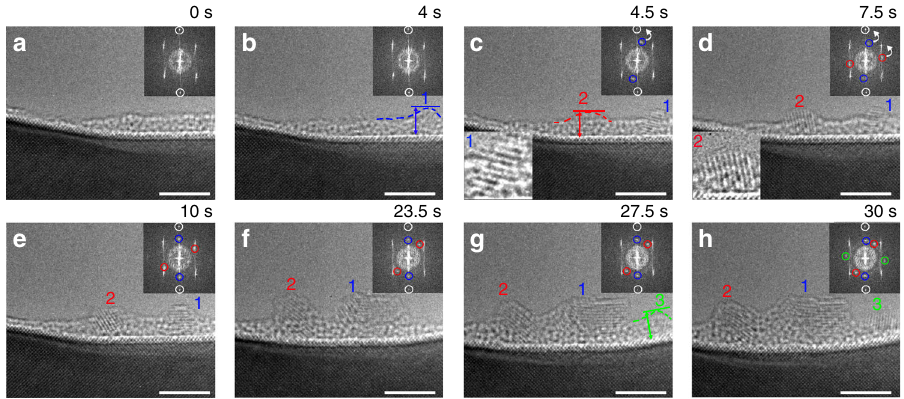
Fig. 3 Amorphous-to-crystalline transition and grain rotation of Au clusters. The in situ observations were performed at 600 °C and 1 × 10 − 3 Torr of H 2 gas fl ow (Supplementary Movie 2). a – d The aggregation of Au atoms results in the formation of clusters 1 and 2 that subsequently transform into a crystalline state with the appearance of Au(111) lattice planes and cluster rotation. e , f Growth of crystalized clusters, where cluster 1 stays relatively stationary while cluster 2 undergoes slow rotation. The insets in c , d are the zoom-in view showing the presence of crystalline lattice in clusters 1 and 2. g , h Nucleation and growth of cluster 3 followed by subsequent amorphous-to-crystalline transition and grain rotation. Bottom-left: zoom-in view of clusters 1 and 2 in ( c , d ) respectively. Top-right: Fourier diffractograms, white rings circle out the (220) spot pair of the Cu(Au) solid solution; blue and red rings circle out the Au(111) diffraction spot pairs of clusters 1 and 2, respectively; and green rings circle out Au(200) diffraction spot pair associated with cluster 3. The white arrows in ( c , d ) mark the rotation direction of the clusters that results in the alignment of the (111) spot pairs of the Au clusters with the (200) spot pairs of the substrate. Scale bar, 4 nm ( a – h